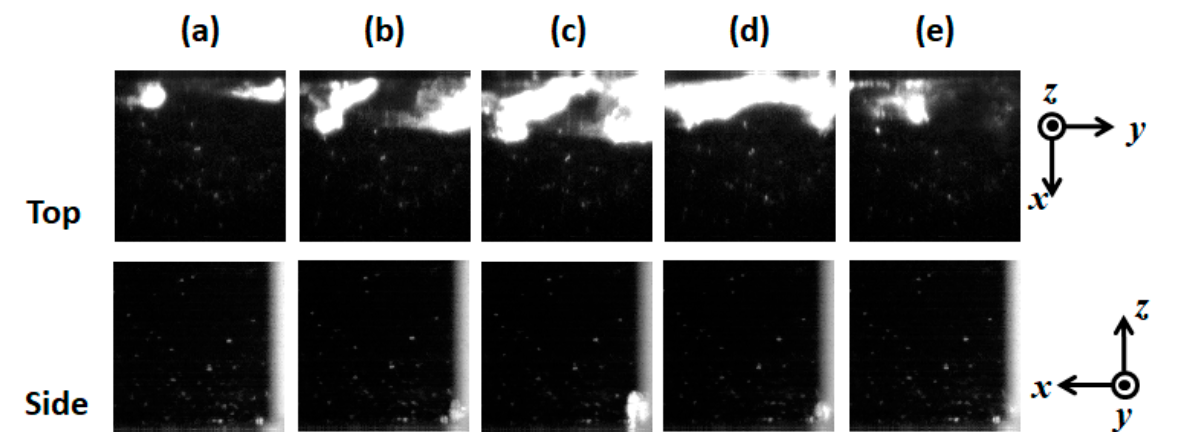
Figure 6. Instantaneous visualization using the synchronized signal with two high-speed cameras at a heat flux of 1.1 MW/m 2 : ( a ) 689.8 ms, ( b ) 690.3 ms, ( c ) 690.7 ms, ( d ) 690.9 ms, and ( e ) 691.2 ms.